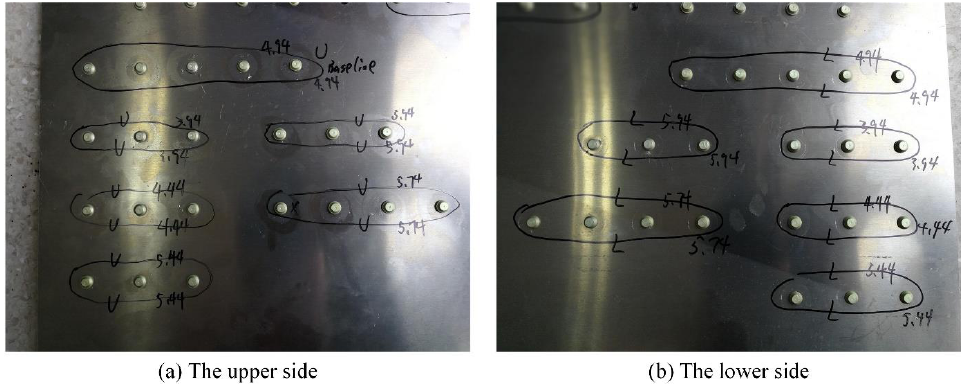
Figure 17. The specimen after riveting. ( a ) The upper side; ( b ) The lower side. Interference level is considered as the main quality control criterion for riveted as- sembly. Figure 18 shows the comparison of the interference condition after the riveting process. The comparisons between the numerical results and experimental measurements are satisfactory in terms of both interference value and its variation trend.